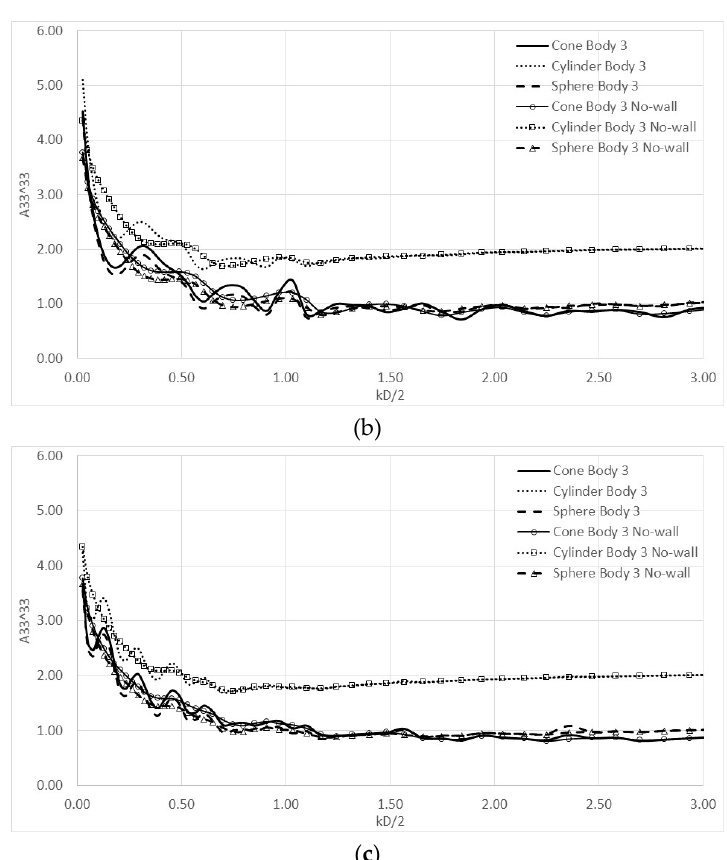
Figure 17. Dimensionless added mass of the 3rd floater at the heave direction due to its motion at heave against kD/2, for the three different examined array configurations. Comparison with the corresponding added mass on the same floater of the arrays without the presence of the breakwater: ( a ) parallel arrangement, C 1 ; ( b ) rectangular arrangement, C 2 ; ( c ) perpendicular arrangement, C 3 .